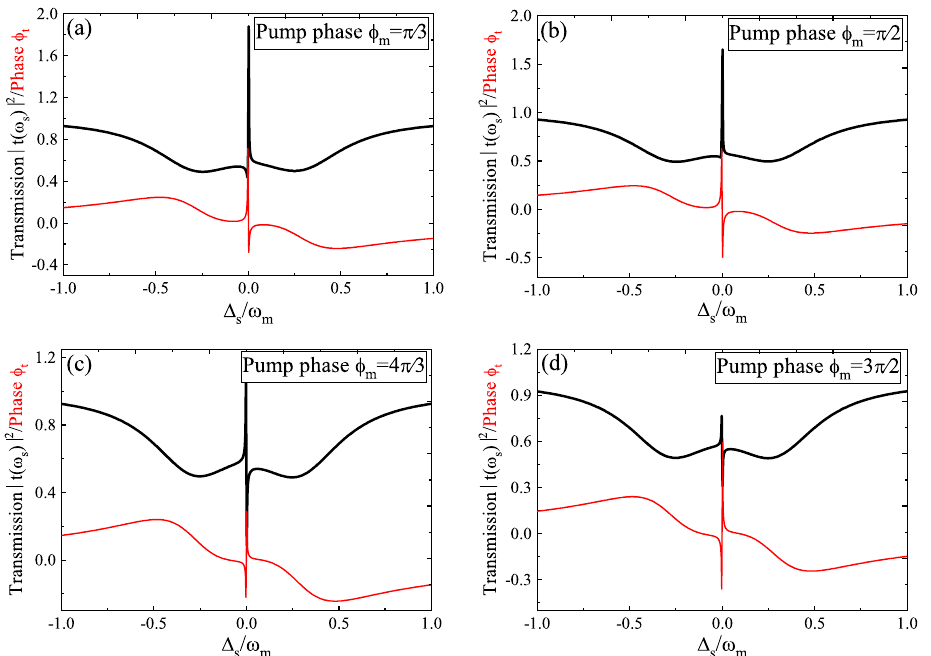
Figure 4. The transmission T and phase φ t as a function of ∆ s for four different pump phases ϕ m : ( a ) ϕ m = π /3; ( b ) ϕ m = π /2; ( c ) ϕ m = 4 π /3; ( d ) ϕ m = 3 π /2. Figure 5a plots the group delay τ g versus the optical pump power P for two different pump phases of ϕ m = π /3 and ϕ m = π /2 at f = 0.5 fN. The results indicated that